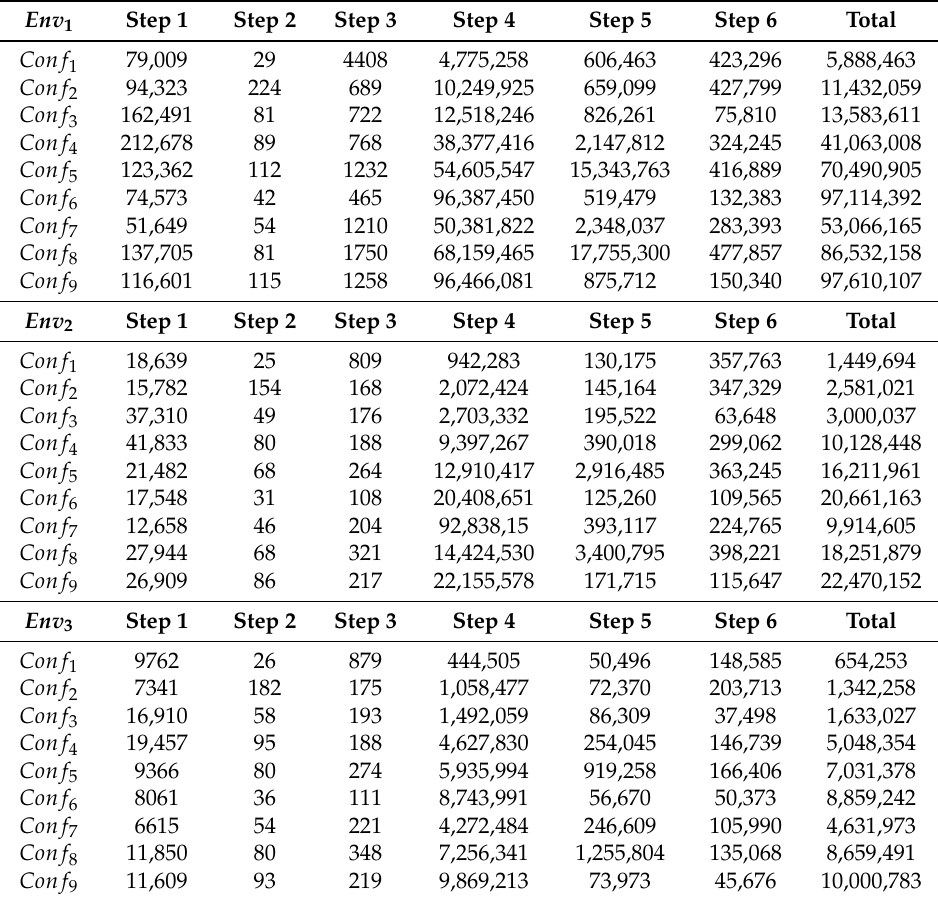
Table 7. Execution times for the corpus of 15,000 data sets (first Map-Reduce